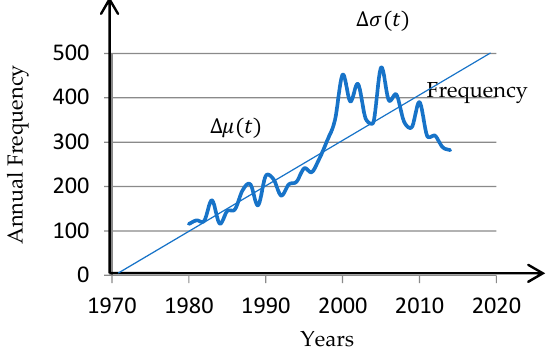
Figure 3. Shows Components Extreme Events cycles. Note: Figure shows yearly frequency trend of disaster events in developing and emerging economies (Source: EM-Dat).